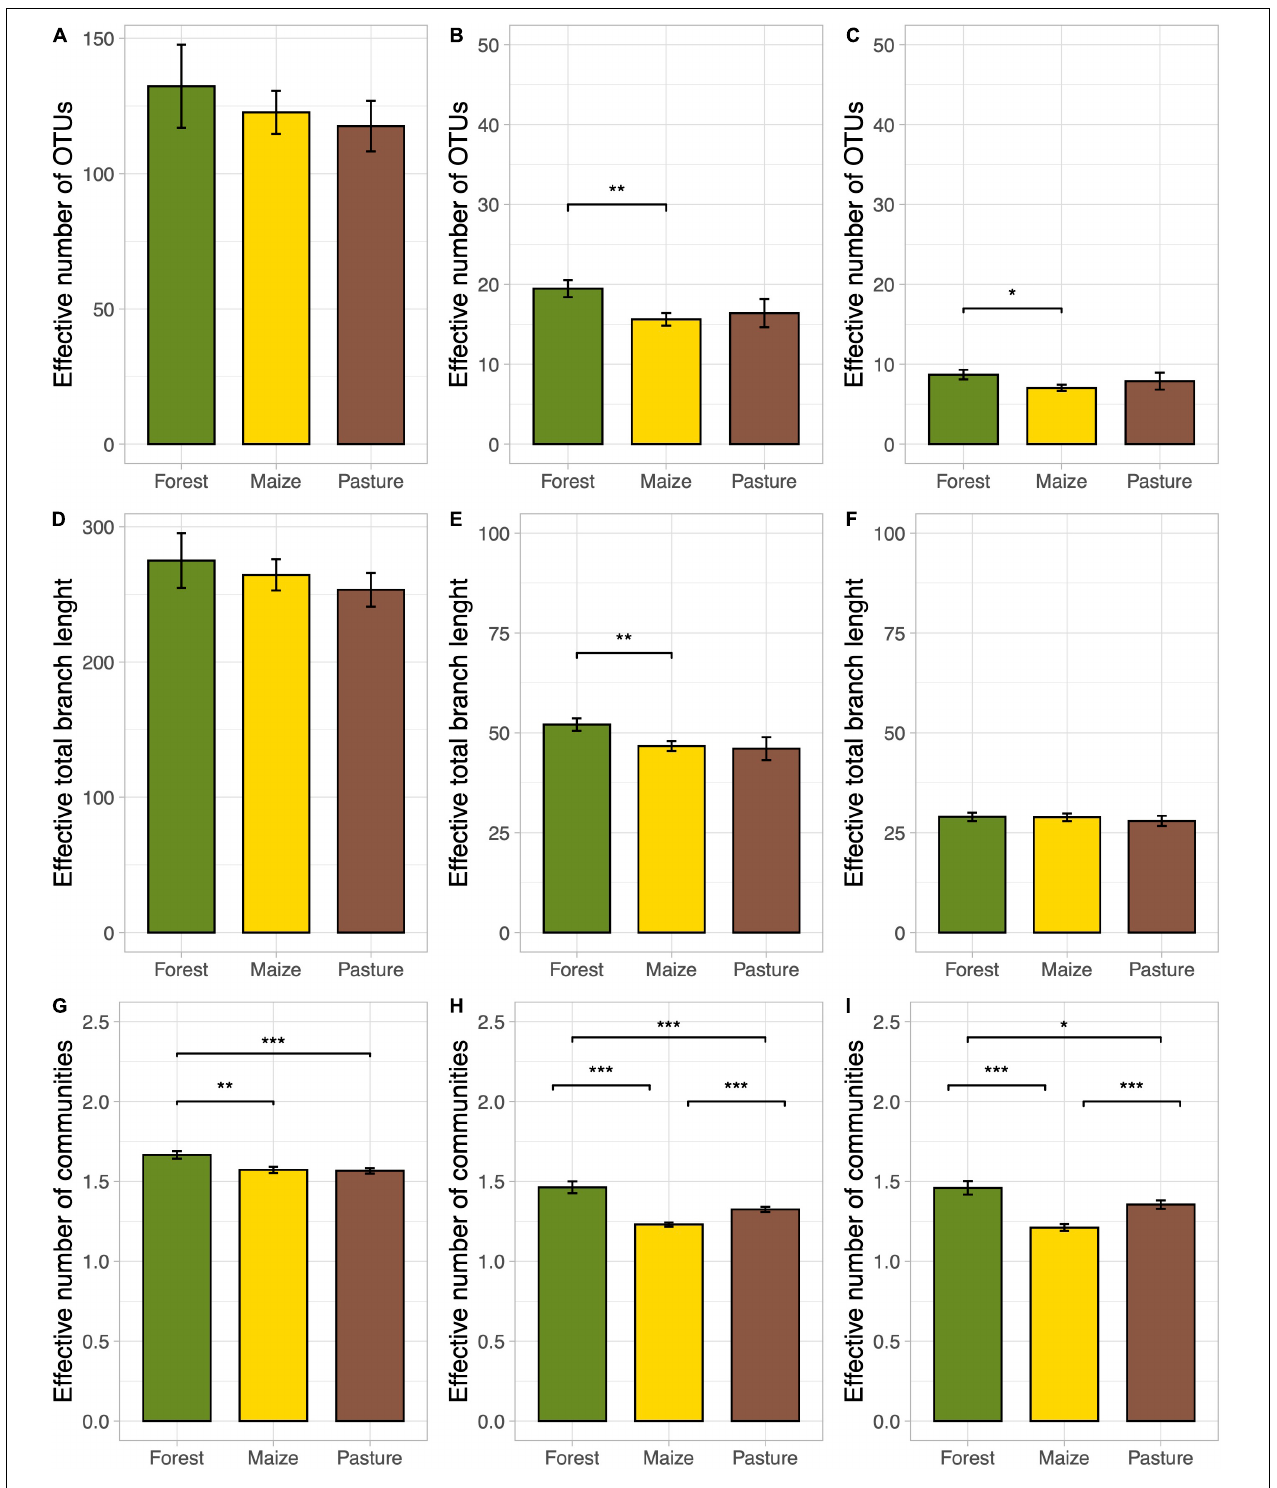
FIGURE 1 | Bar plots of the true diversity parameters of the fungal communities in a coniferous forest soil (Forest), deforested for grazing (Pasture), and in maize ( Z. mays L.) cultivated deforested soil (Maize) at the “ Área de Protección de Flora y Fauna Nevado de Toluca ” (Mexico). The bar height indicates the mean for each land use system and the error lines indicate the standard error of the mean. Taxonomic alpha diversity (A–C) , phylogenetic alpha diversity (D–F) , and taxonomic beta diversity (G–I) were calculated at diversity orders q = 0 (A,D,G) , q = 1 (B,E,H) , q = 2 (C,F,I) . Linear mixed effects models with 1000 Monte-Carlo permutations and locality as random factor (* p < 0.05, ** p < 0.01, *** p < 0.001) was used to test the significant differences.